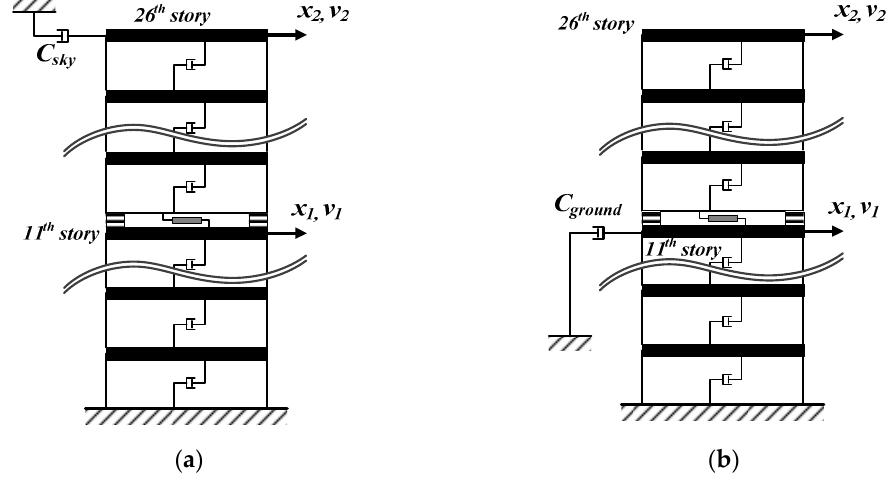
Figure 12. Idealized semi-active control configurations: ( a ) skyhook, ( b ) groundhook. The relative velocity between the roof story and the 11th story, i.e., v 1 − v 2 in Figure 12, is an important value for the development of the skyhook and groundhook